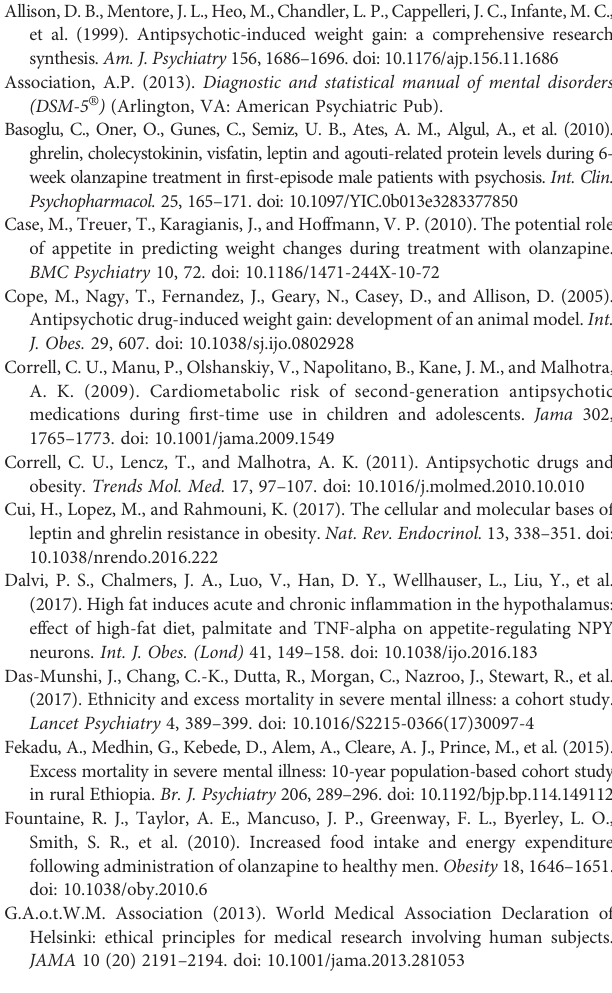
controlling for age, duration of illness, and gender.